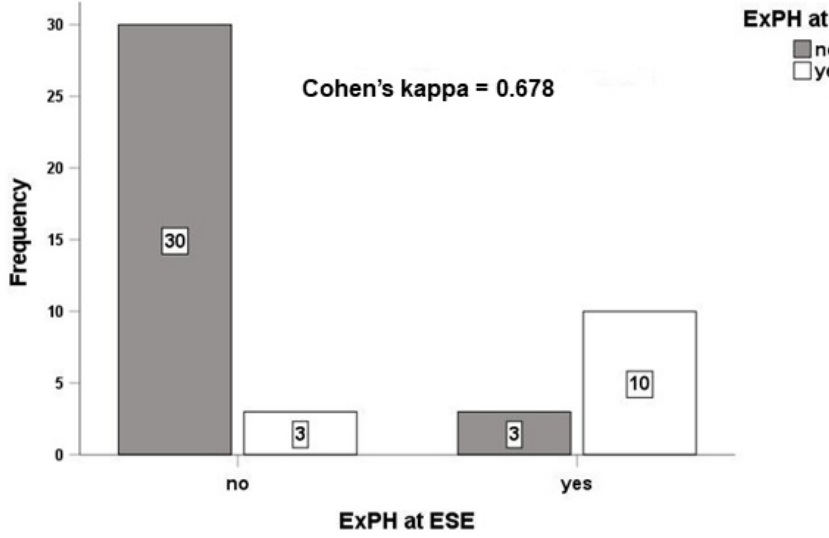
Figure 1. Concordance of exercise stress echocardiography and the cardiopulmonary exercise test in the diagnosis of isolated exercise pulmonary hypertension. Abbreviations: ESE, exercise stress echocardiogram; ExPH, exercise-induced pulmonary hypertension; CPET, cardiopulmonary exer- cise test.